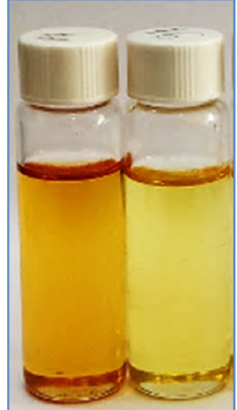
Figure 1. Photographic view of color of aromatic oil, DH: direct heat, IH: indirect